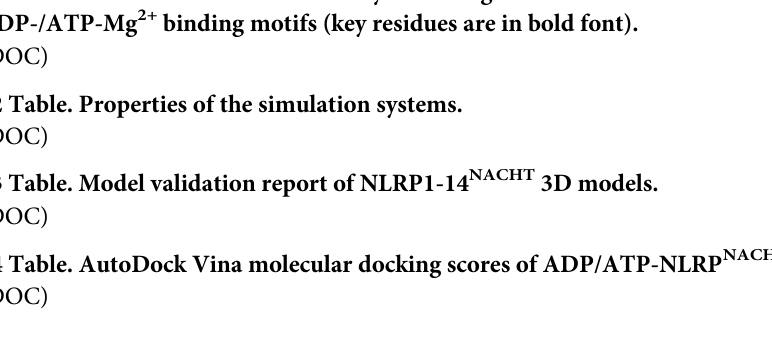
S1 Table. Overview of NLRP-subfamily according to their domain distribution and key